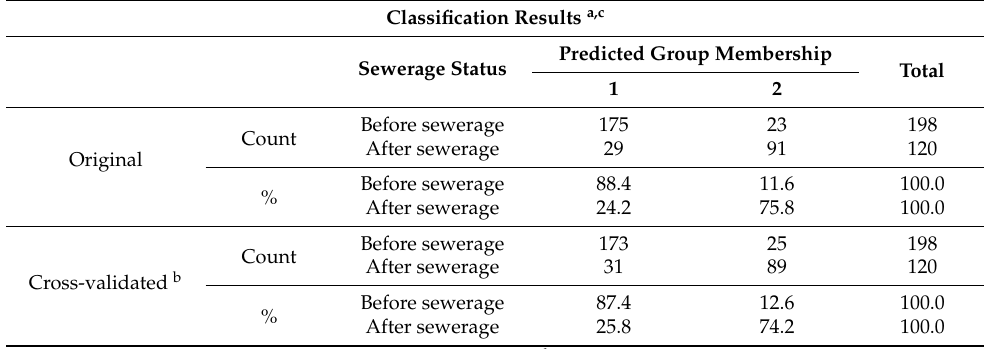
Table 2. Classification results of the discriminant